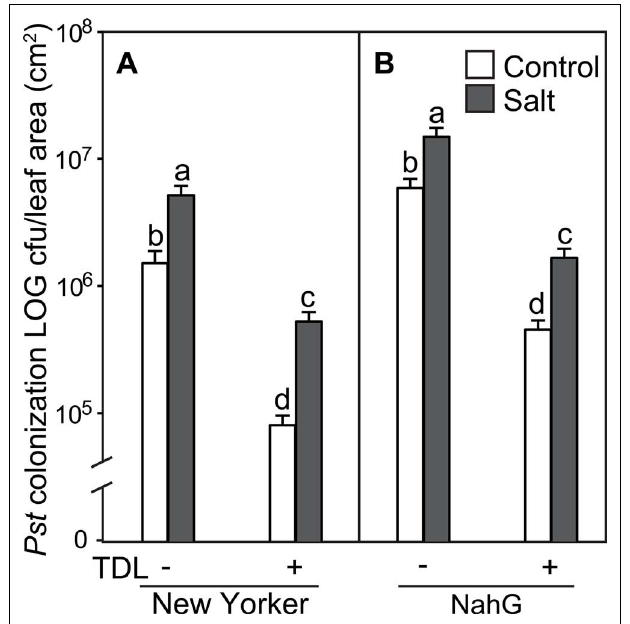
FIGURE 2 | Pseudomonas syringae pv. tomato colonization in (A)WT background (“NewYorker”) and (B) NahG tomato leaves. Roots were pretreated withTDL for 7 days and then exposed for 18 h to salt stress (0.2 M NaCl/0.02 M CaCl 2 ). Shoots were dip-inoculated with a suspension of Pst adjusted to 10 7 cfu ml − 1 . Colonization was evaluated 4 dpi. Bars represent the means ± SE from three expriments, n = 15. Letters above bars indicate significant differences between treatments at α = 0.05 using theTukey–Kramer test for mean